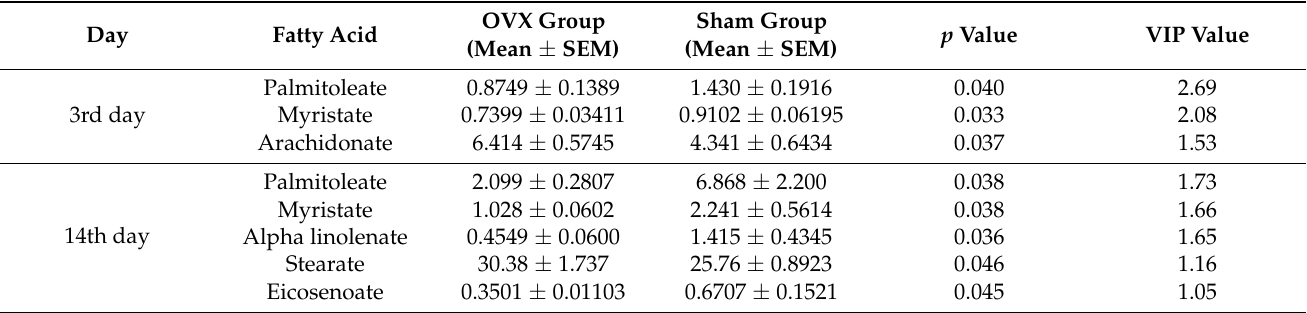
Figure 2. Multivariate statistical analysis of GC-MS data. OPLS-DA score plots and permutation test results of bone marrow fatty acids 3 ( A , B ) and 14 ( D , E ) days after OVX surgery ( n = 8 rats per group). ( C , F ) VIP plot of the OPLS-DA model. Screening criteria for fatty acids: VIP ≥ 1. N: Sham group, O: OVX group. Color of square indicates fatty acids content, red: high content and blue: low content. Table 1. OPLS-DA and t -test results of fatty